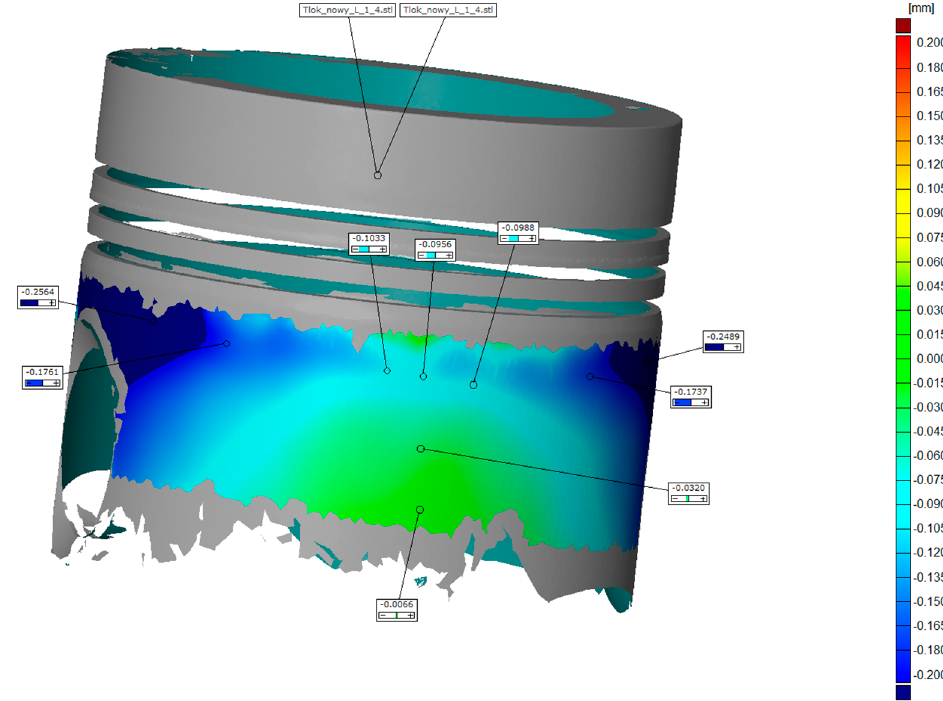
Figure 10. Examples of deviations from the diameters of the replacement element of the piston.